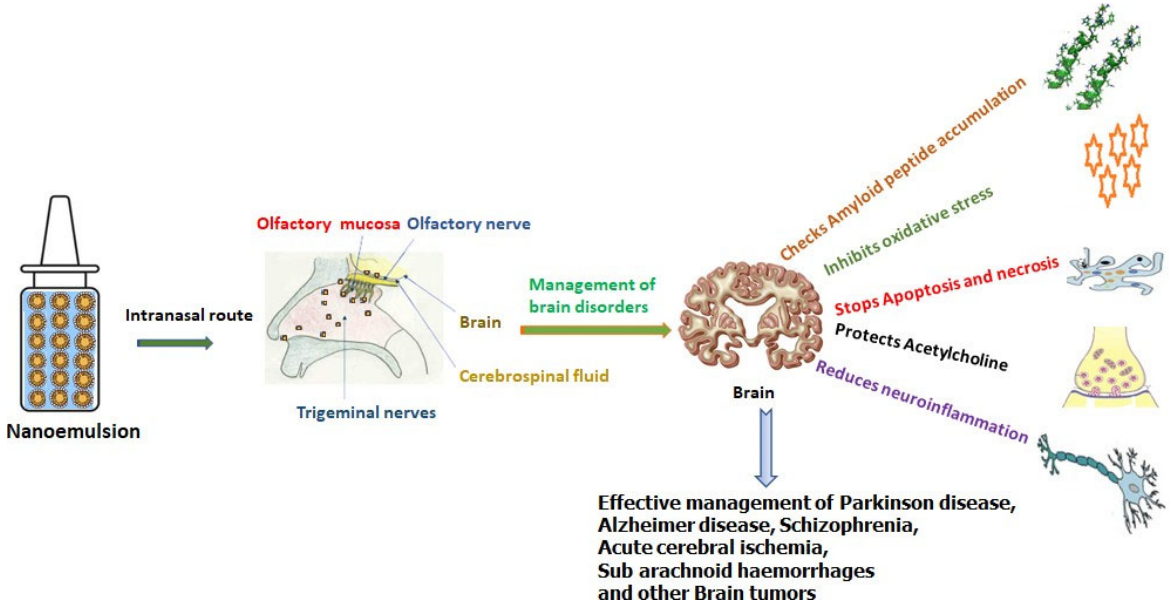
Figure 2. Intra nasal delivered nanoemulsion and management of brain disorders.